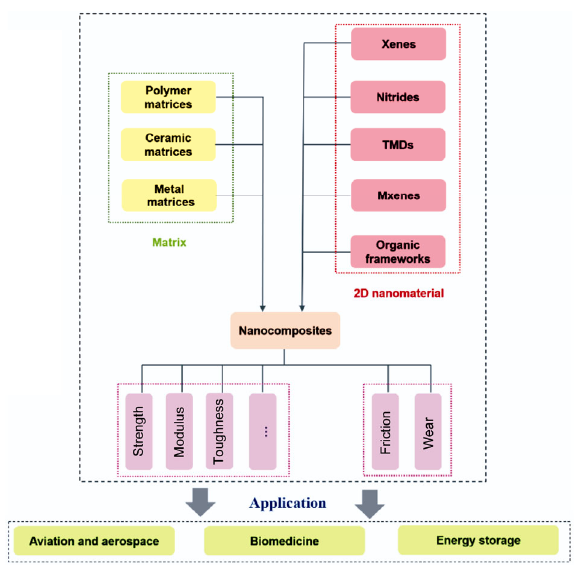
Fig. 3 Basic framework of this